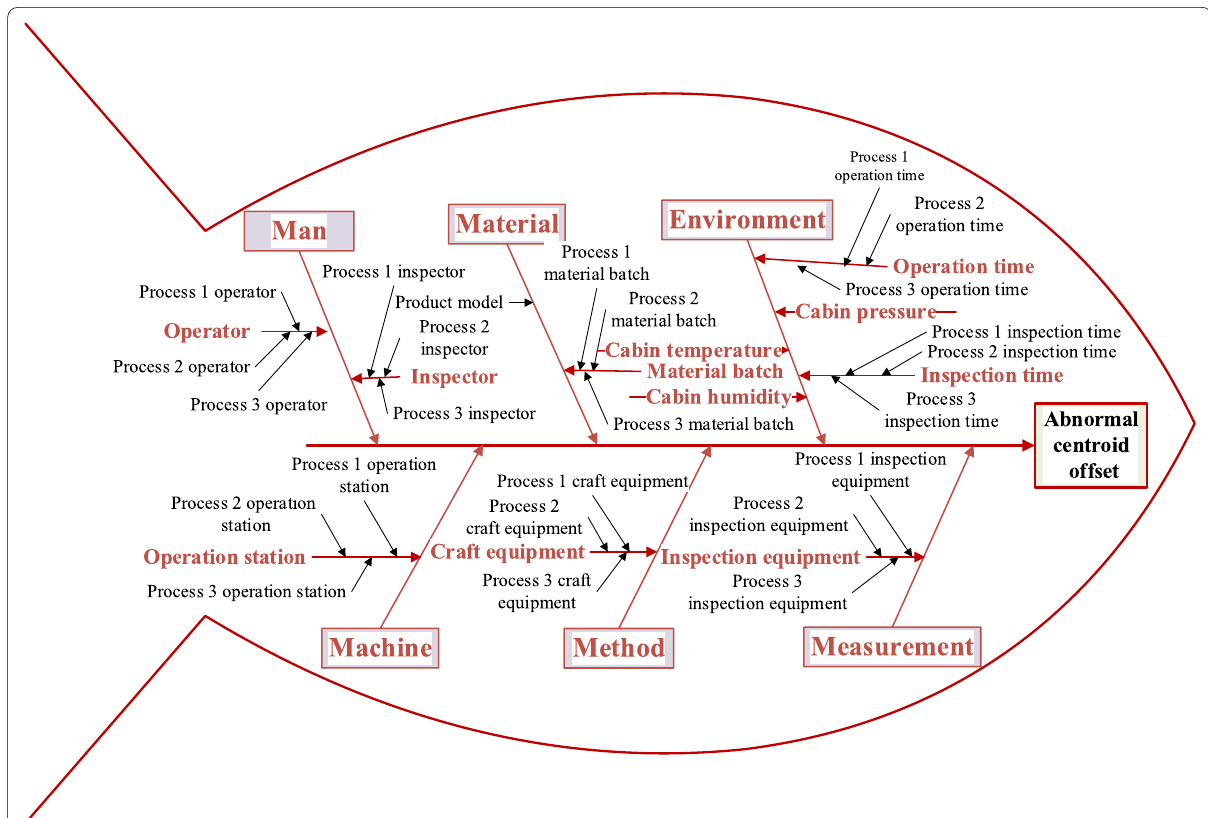
Figure 8 Fishbone diagram of influencing factors for centroid offset of cabin A